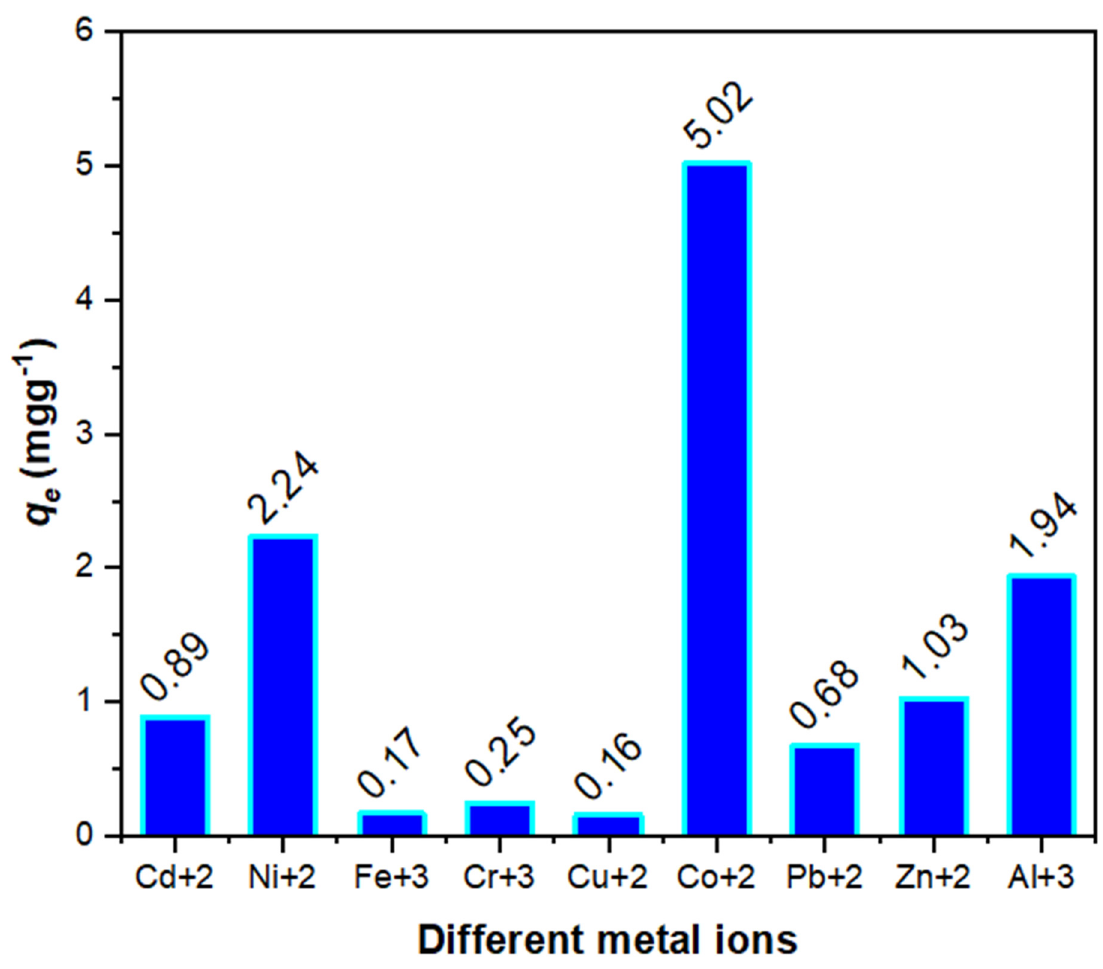
Figure 7. Surface study of selectivity for A-SPES against different metal ions.